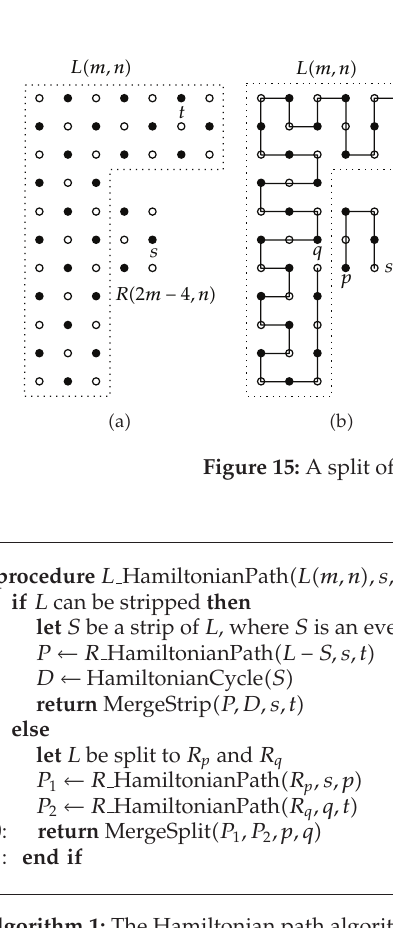
Algorithm 1: The Hamiltonian path algorithm for L -alphabet grid